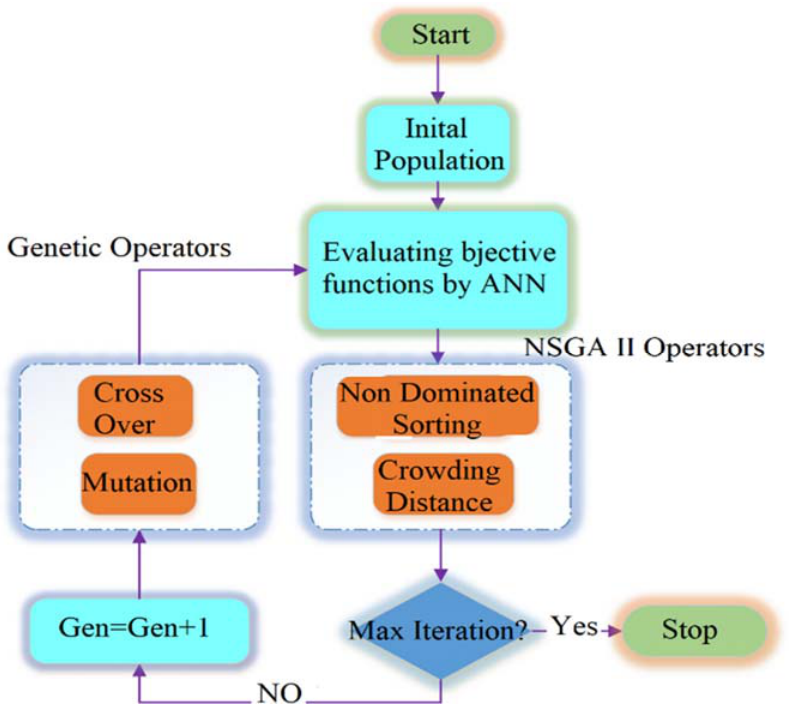
Figure 23: Optimization flowchart.